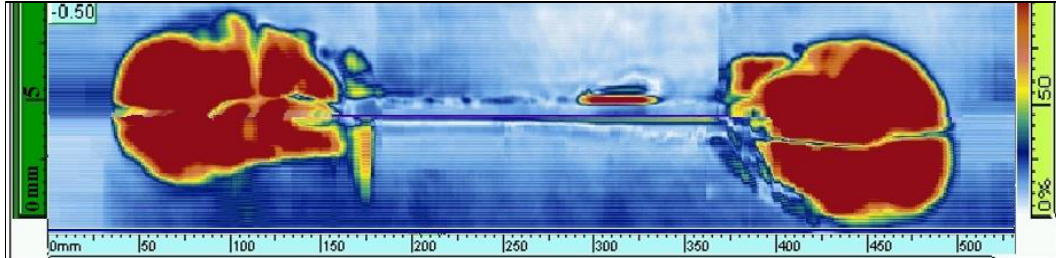
Figure 17. C-scan inspection over the multi-stringer component’s surface on damaged zone along the artificial cut and an example of A-scan and S-scan on right side delamination.